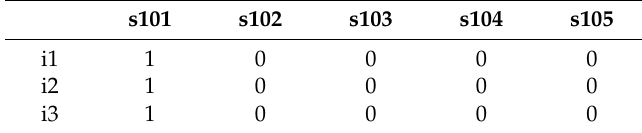
Table A1. Units map gen_map( i , s ): includes the position of each unit in the power system.